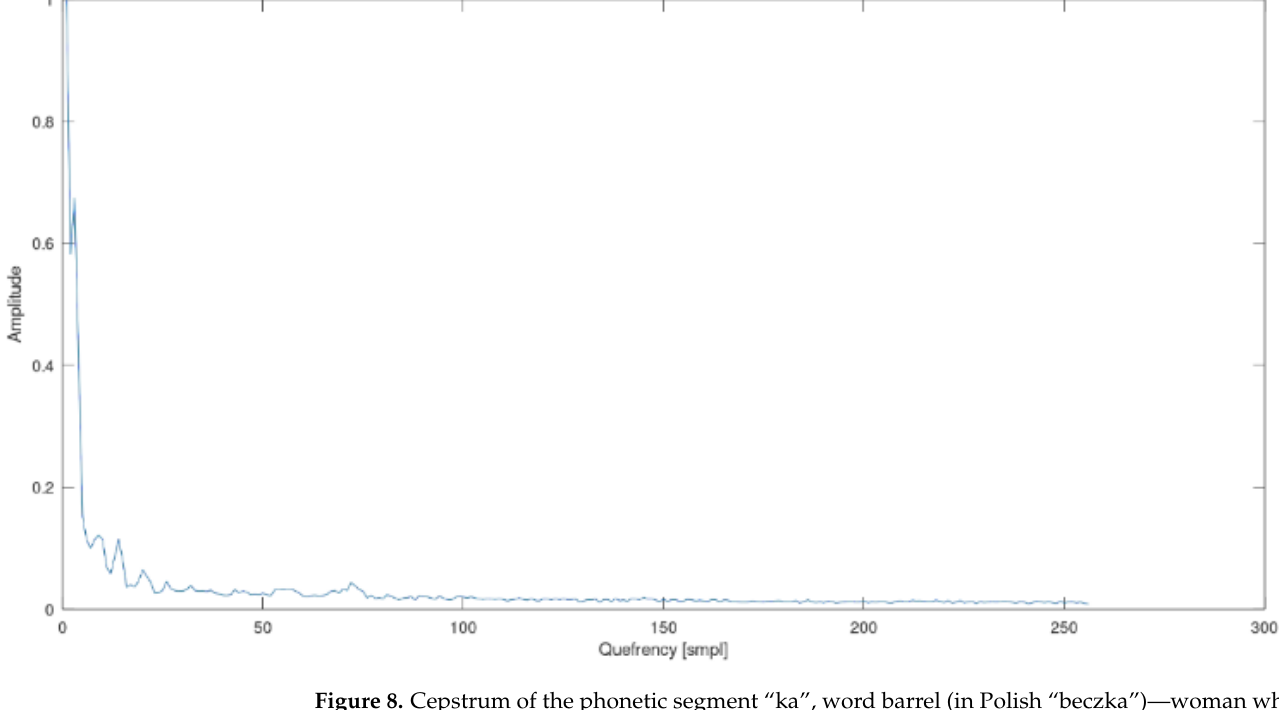
Figure 8. Cepstrum of the phonetic segment “ka”, word barrel (in Polish “beczka”)—woman who has undergone a laryngectomy.